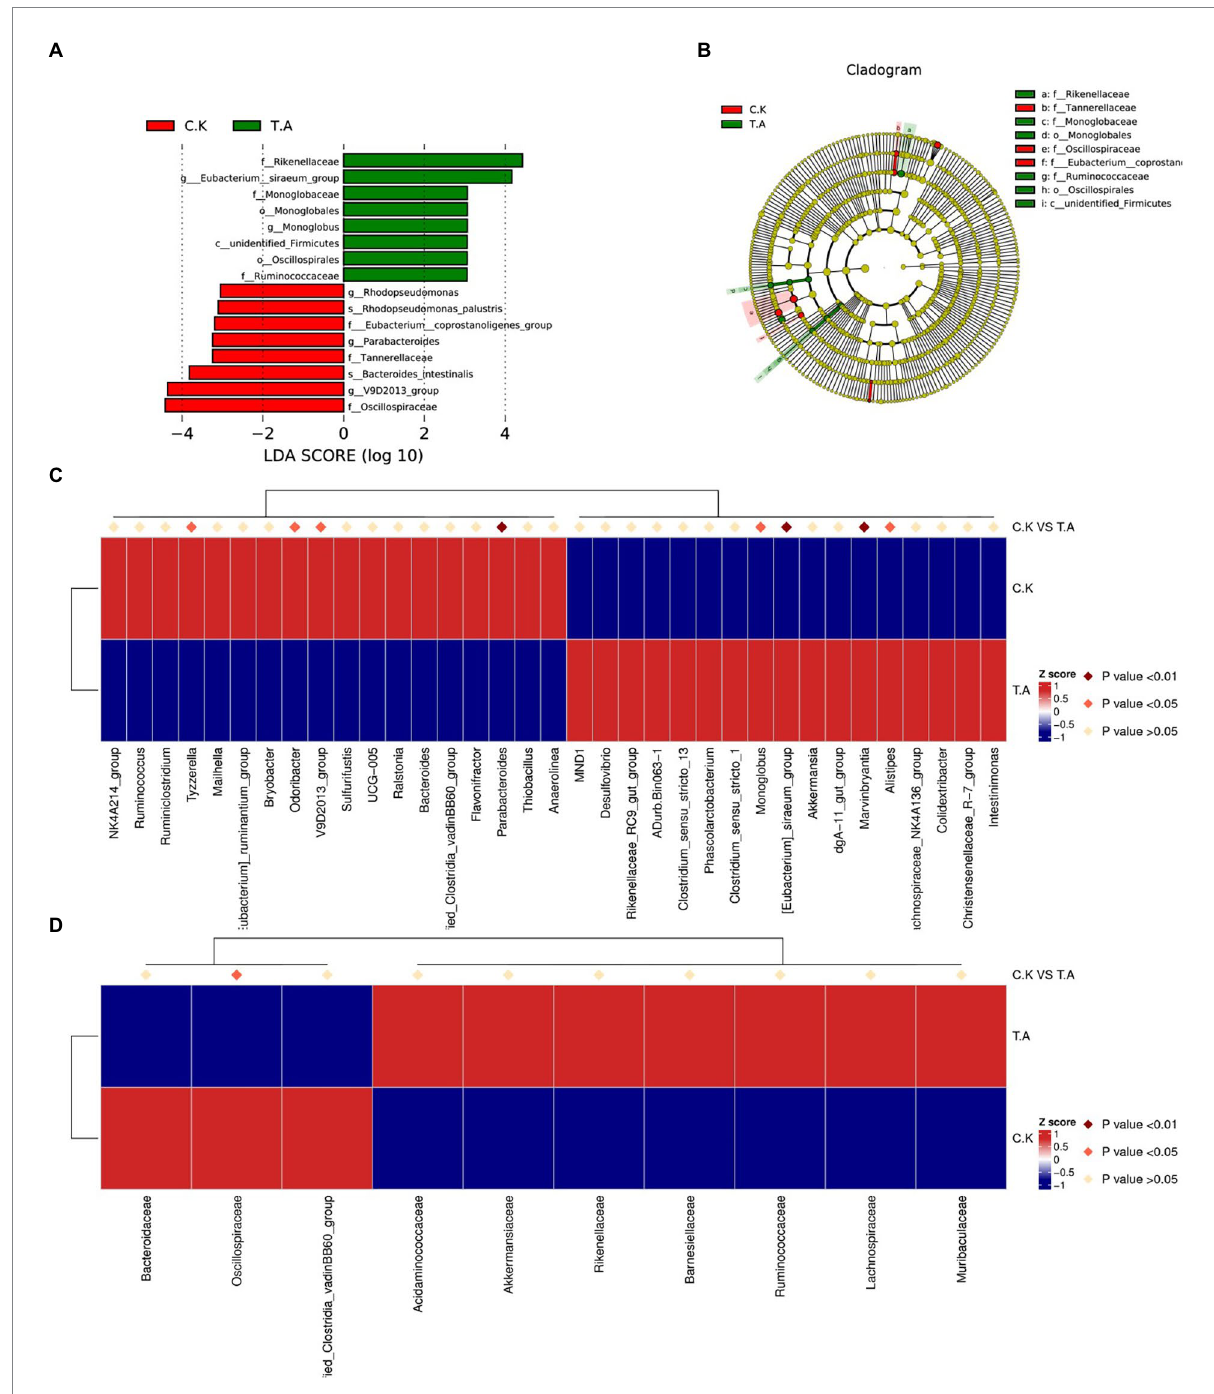
FIGURE 2 Analysis of cecum microbial community composition differences in rabbits. (A) Bar chart of the distribution of LDA values of species with significant differences between control and LNT (TA) ( p < 0.05, LDA > 3). (B) Phylogenetic tree plot of significantly different species between control and LNT (TA). (C) Heatmap of differential species between control and LNT (TA) at genus level. (D) Heatmap of differential species between control and LNT (TA) at family